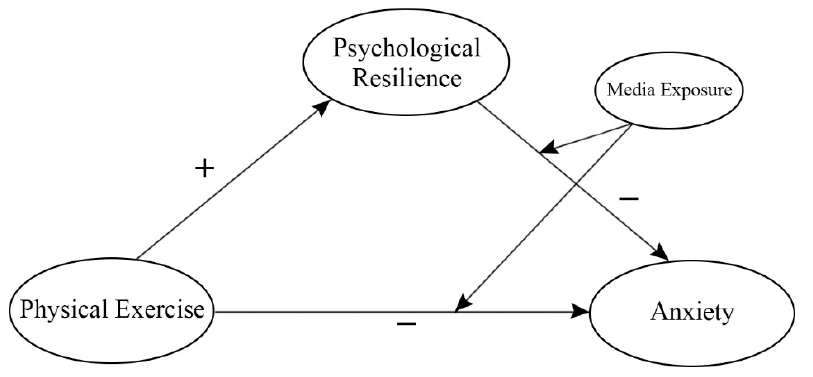
Figure 1. Conceptual framework.